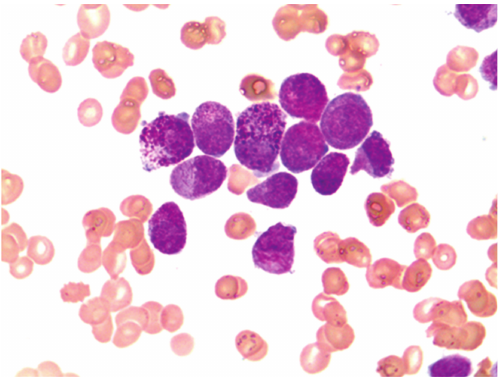
Figure 1: Heavily granulated promyelocytes and auer rods in peripheral blood.